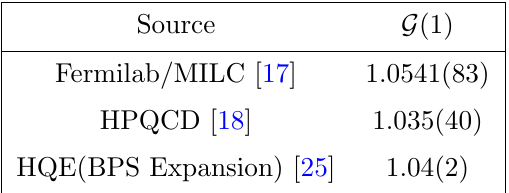
Table 2 . Di(cid:11)erent values of G (1) used in B ! D‘(cid:23) ‘